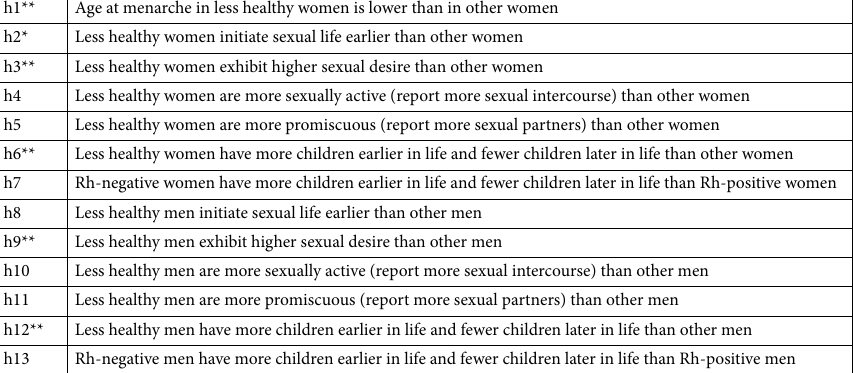
The multivariate multiple GLM analysis with age at first sexual intercourse, sexual desire, sexual activity, number of sexual partners, number of children, and age at menarche in women as dependent variables and age, socioeconomic status, current partnership, height, size of place of residence, education, church membership, sickness index, and interaction between the sickness index and age as independent variables showed a signifi- cant effect of the sickness index on variables related to sexual life and reproduction in both women (p < 0.005, η 2 = 0.011) and men (p < 0.005, η 2 = 0.013). Subsequent eleven univariate GLM analyses (Table 2) showed a significant negative association of the sickness index with age at menarche in women and a significant positive association with sexual desire in both women and men. These results thus support hypotheses h1, h3, and h9. Interaction between the sickness index and age had a significant effect on the number of children in both women and men. Contour plots suggest that healthier